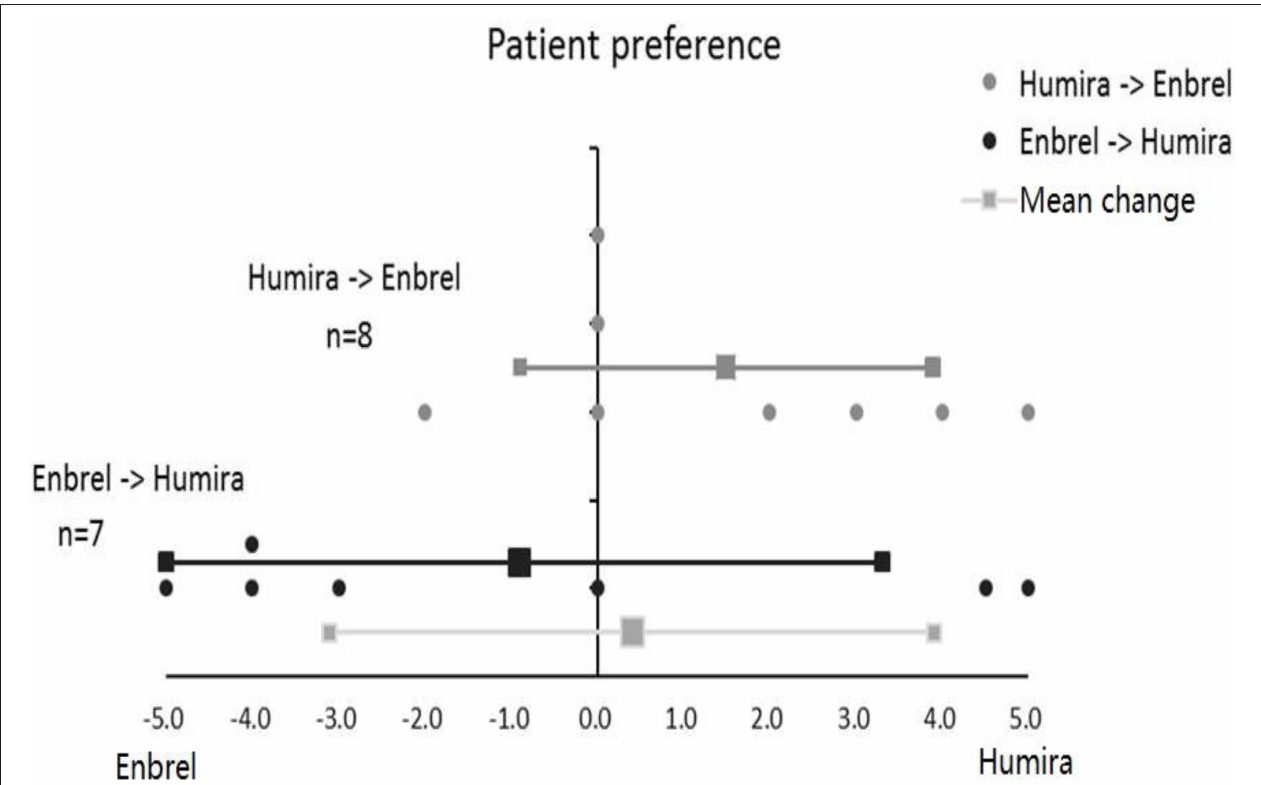
FIGURE 5 | Patient preference for Enbrel and Humira in the treatment arm and the control arm. Totally seven patients were graded in the treatment arm, and eight patients were graded in the control arm.